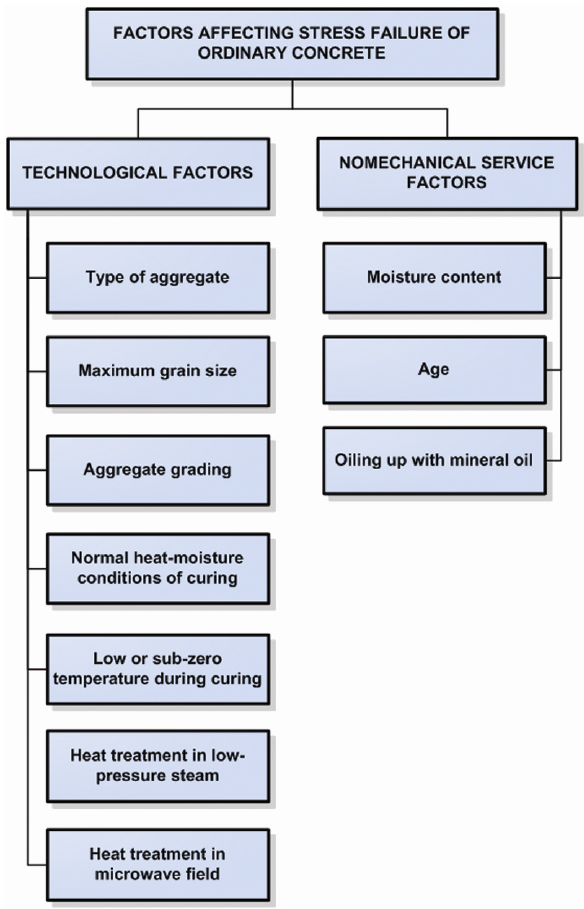
Fig. 1. Major technological and nomechanical service factors affecting stress failure of ordinary concrete under compression